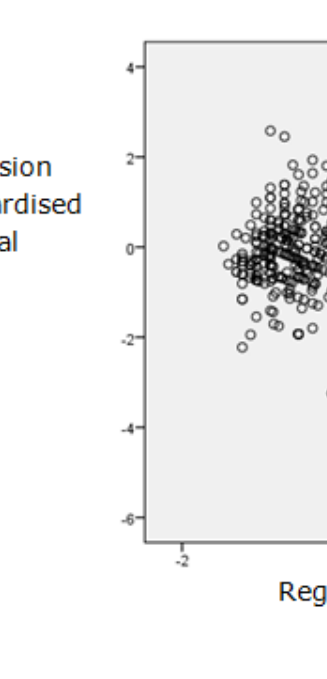
Figure 2. Standardised residual versus standardised predicted value plot